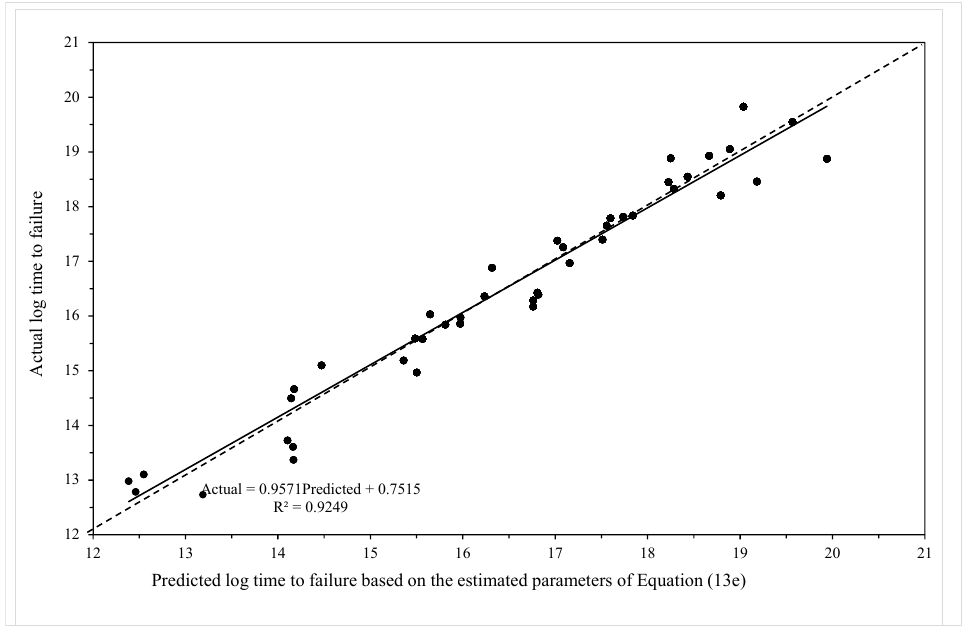
Actual = 0.9571Predicted + 0.7515 R² = 0.9249